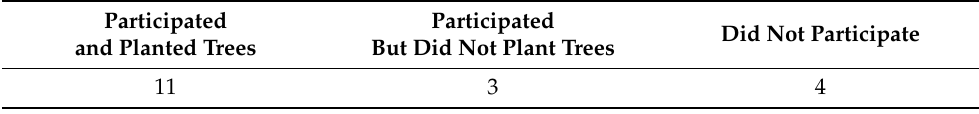
Table 6. Participation in the Hiraenoki Reconstruction Tree Planting Ceremony.